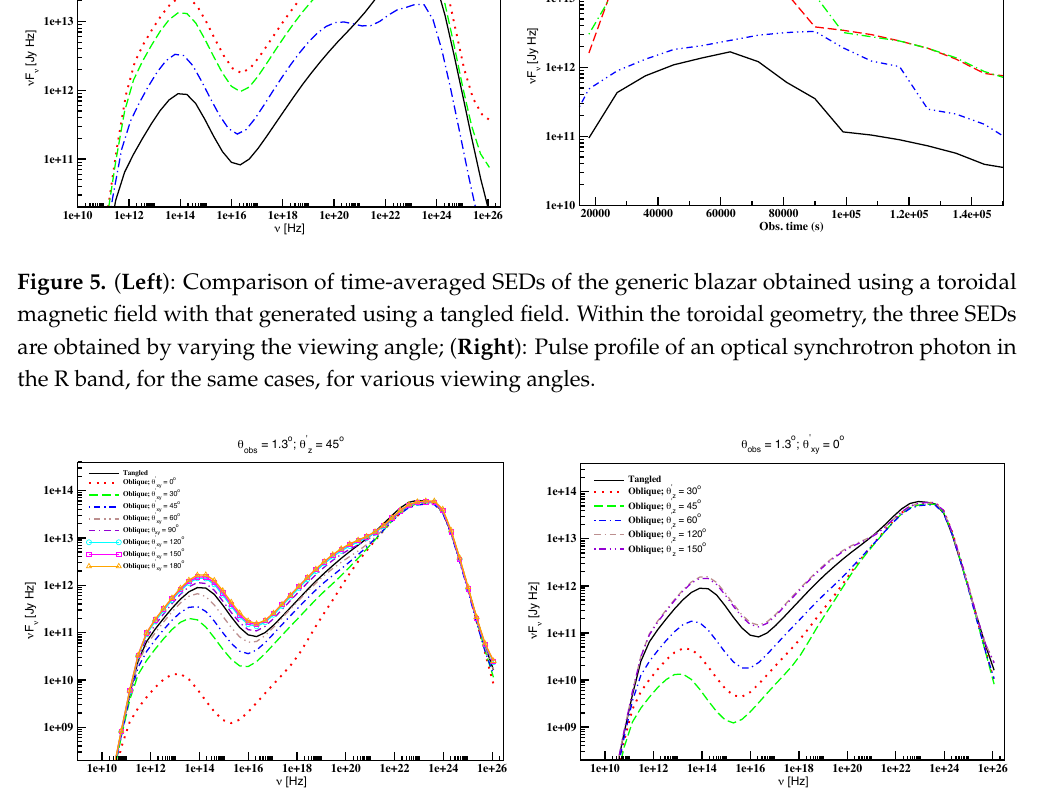
Figure 6. ( Left ): Comparison of the time-averaged SED of the generic blazar obtained using a tangled magnetic field with those obtained using an oblique field. Within the oblique geometry, the SEDs are obtained by varying value of θ (cid:48) xy ; ( Right ): Comparison of the same with time-averaged SEDs generated for different obliquities of the magnetic field with a fixed value of θ (cid:48) xy